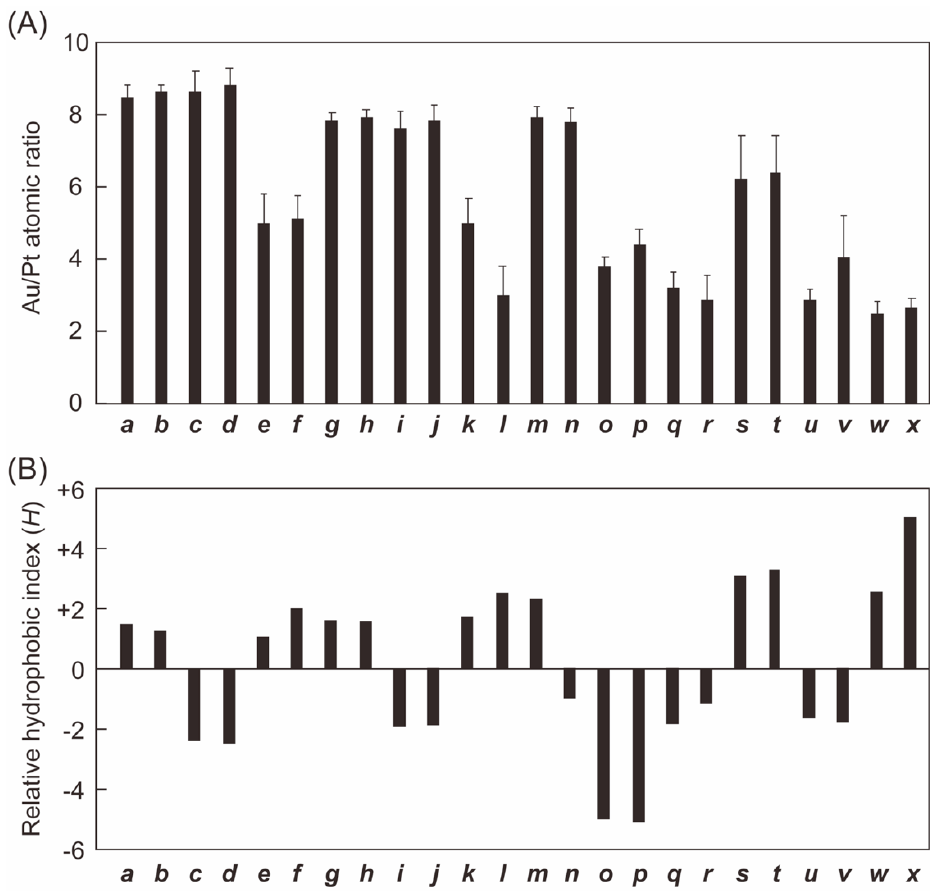
Figure 2. ( A ) Au-to-Pt (Au/Pt) atomic ratios for precipitates obtained from mixtures of HAuCl 4 , H 2 PtCl 6 and peptides a – x as determined by EDS-FESEM analyses of randomly selected areas (mean ± SD, n = 12–27). Peptide = 2.0 × 10 − 4 M, HAuCl 4 = H 2 PtCl 6 = 5.0 × 10 − 5 M in water. Reactions were conducted at 40 ° C for 24 h in the dark. ( B ) Relative hydrophobic index ( H ) values for peptides a – x as determined by reverse-phase HPLC. Positive and negative values indicate hydrophobic and hydrophilic materials, respectively.